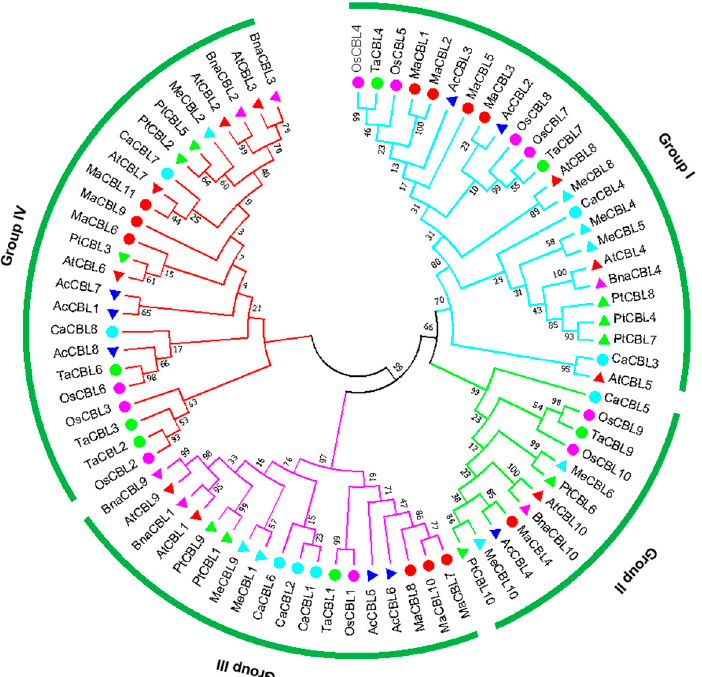
Figure 1. Phylogenetic tree of banana calcineurin B-like proteins (CBLs), with specific CBLs that characterize different species. Ma, At, Os, Ac, Ta, Ca, Me, Bna, and Pt denote Musa acuminata , Arabidopsis thaliana , Oryza sativa , Ananas comosus , Triticum aestivum , Capsicum annuum , Manihot esculenta , Brassica napus , and Populus trichocarpa , respectively.